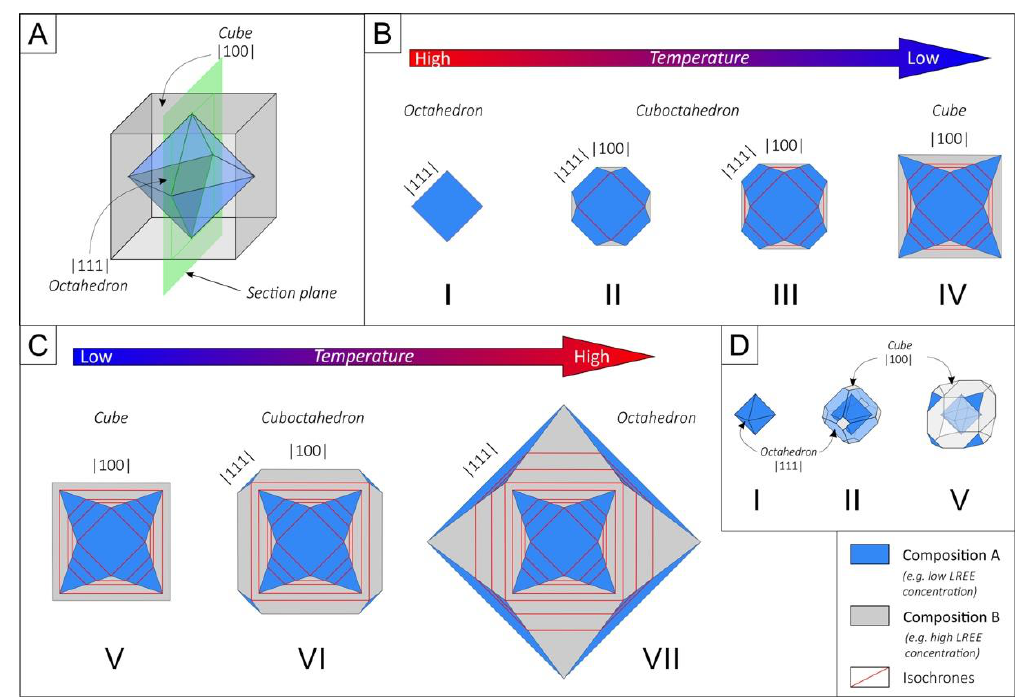
Figure 8. ( A ) Schematic illustration of an idealised cube (grey) and octahedron (blue), respectively. Major crystallographic planes are indicated with respective indices, the section plane used for images in ( B , C ) is marked with green lines. ( B ) Assuming a fluid of constant composition, at higher temperatures fluorite will precipitate in octahedral shape (I) with only |111| planes exposed to the surrounding fluid (blue shade), which results in the preferential incorporation of elements of specific size/charge (compare [23]). Cooling of the fluid will now favour a cubic fluorite morphology and, consequently, the continuous formation of |100| planes (II), which show different sorption properties compared to |111| planes (grey shade). Although precipitating synchronously from the same fluid, two different fluorite generations will form, since the two exposed crystal planes preferentially incorporate different elements. Note, how isochrones of fluorite growth (red lines) crosscut both generations; they represent former crystallographic growth surfaces that were exposed to the hydrothermal fluid at the same time. Continuous cooling will reduce the total area of |111| planes (II-III, cuboctahedron) and finally result in a purely cubic crystal shape (IV). In this example, temperature is the governing factor for crystal morphology and thus, for element incorporation.